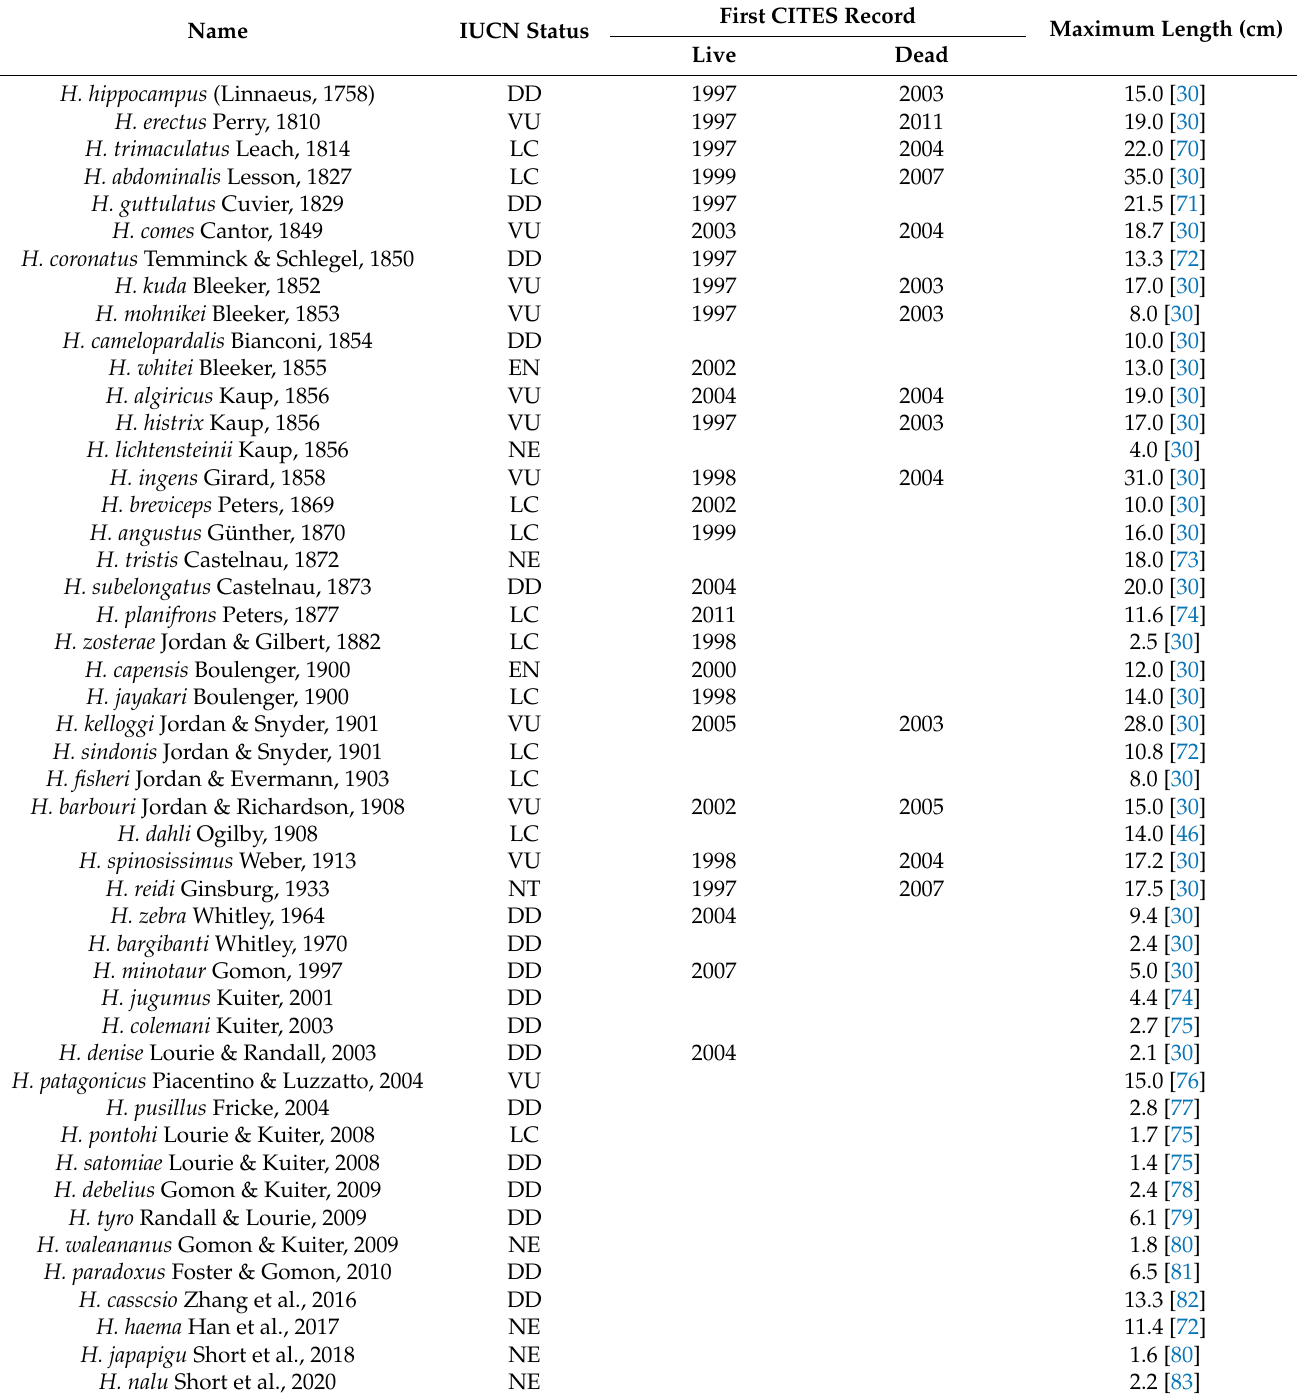
Table 1. Hippocampus species ranked by year of description, with accepted names according to WoRMS [66] and FishBase [67], threat status [68], first year of recorded live or dead specimens (with purpose T = commercial trade) in CITES Trade Database (included if >25 individuals) [69], and maximum recorded length (with references). IUCN Red List categories that apply: NE = Not Evaluated, DD = Data Deficient, LC = Least Concern, VU = Vulnerable, EN =